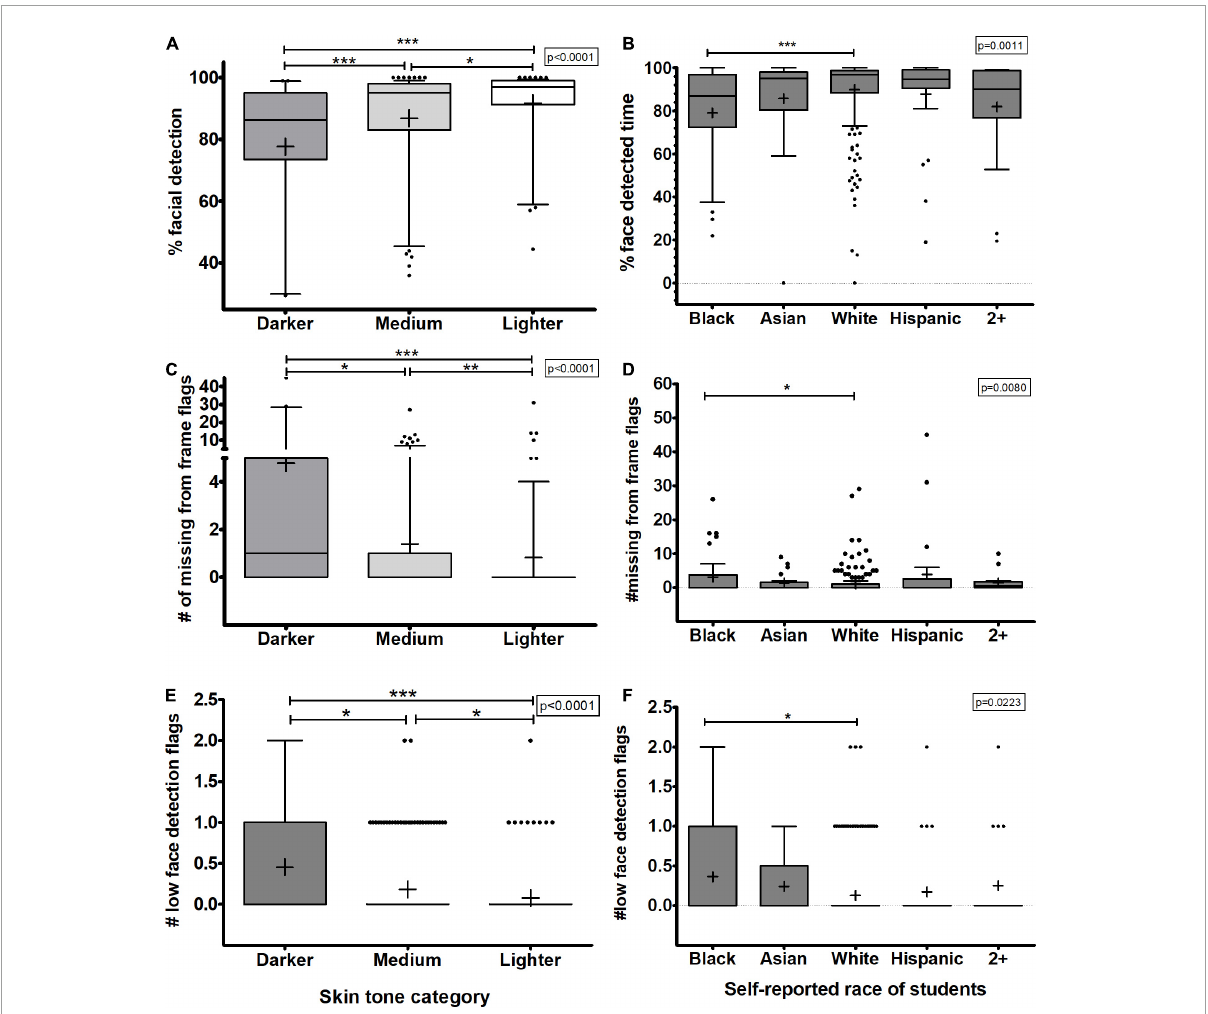
FIGURE2 Facial detection outputs from the automated test proctoring software based on skin tone analysis or self-reported race. (A,B) Percent of time a student’s face was detected during the assessment. (C,D) The number of missing from frame flags for each student. (E,F) Number of low face detection flags for each student are shown. (A,C,E) Show the data analyzed based on skin tone categories while (B,D,F) show the data based on self-reported race. Box plots represent 25 and 75% confidence intervals with whiskers represent Tukey’s distributions and dots represent data outliers. Lines inside the boxes represent the median values and + indicate the mean values. Note the divided y -axis scales on some plots to accommodate the wide range of values. Kruskal Wallis tests yielded an overall p -values indicated on each plot with Dunn’s post-test